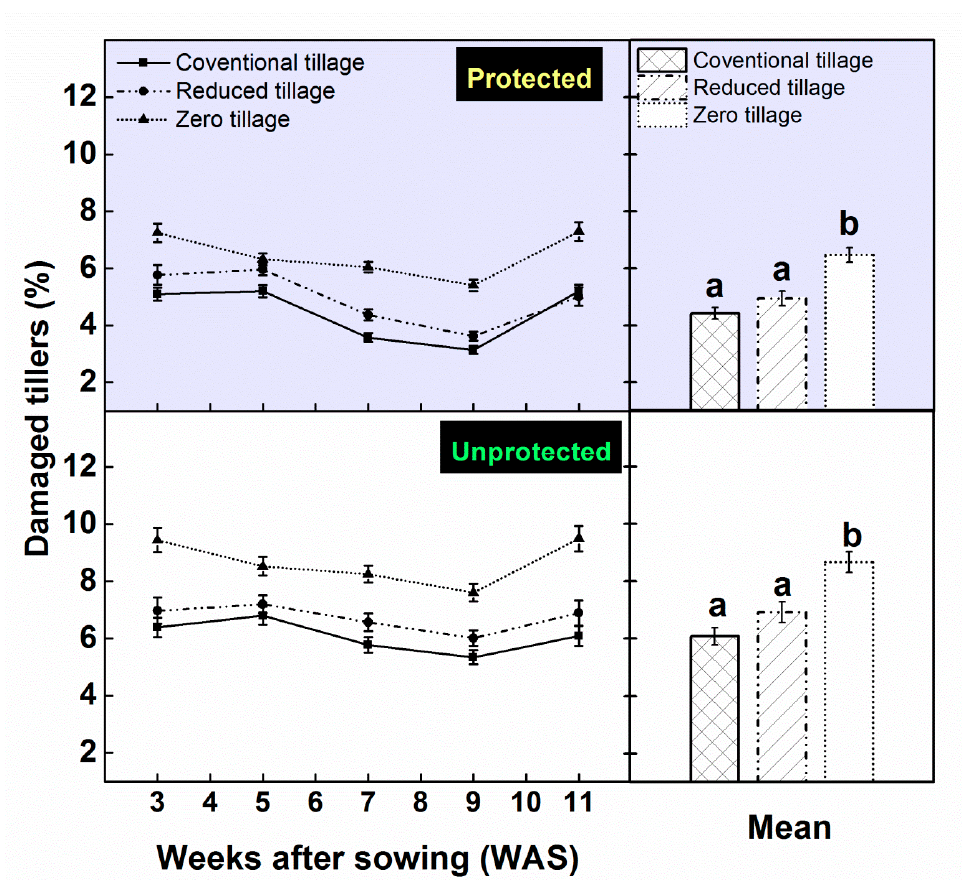
Figure 6. Per cent damage from pink stem borer, Sesamia inferens (Walker), in wheat grown under 3 tillage practices during 2016–2017 and 2017–2018 (pooled). Bars with same letters are not significantly different at p < 0.05. Error bars denote ± 1 SE.